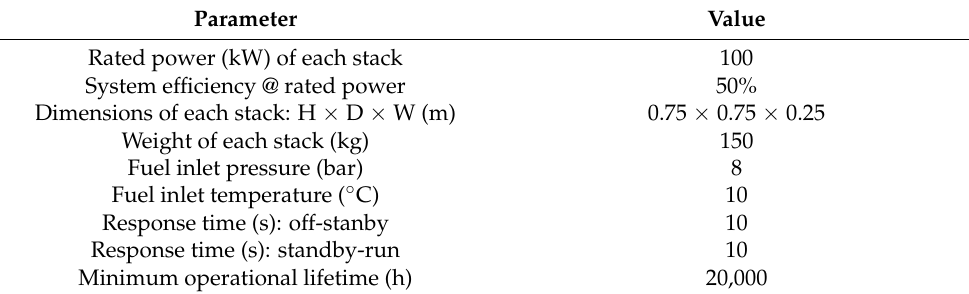
Table 3. Technical data of MS-100 stacks.